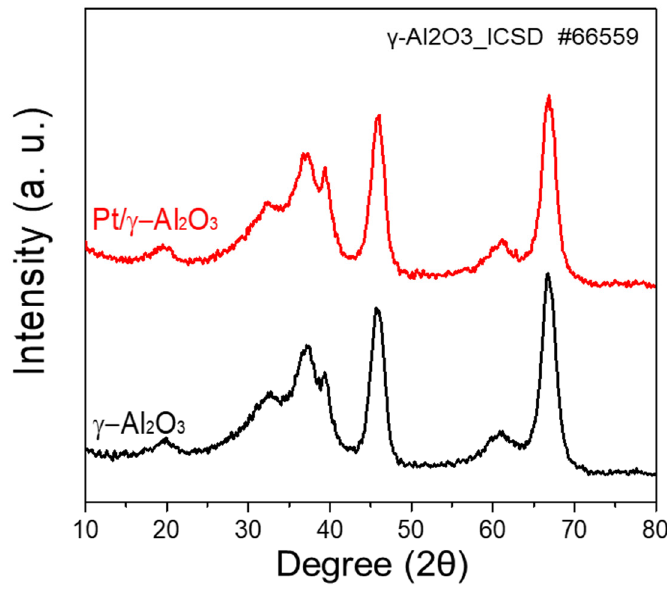
Figure 1. XRD patterns of γ -Al 2 O 3 and Pt/ γ -Al 2 O 3 powders.